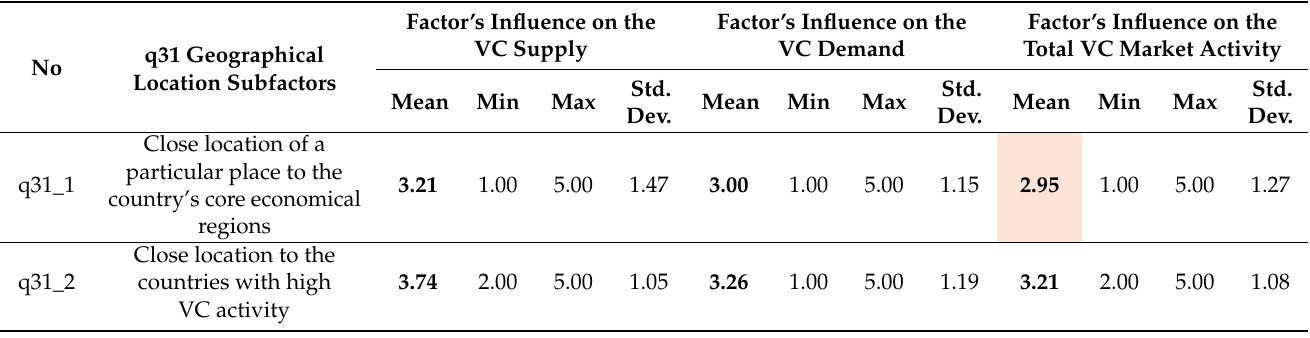
Table 17. The subfactors related to the geographical location.